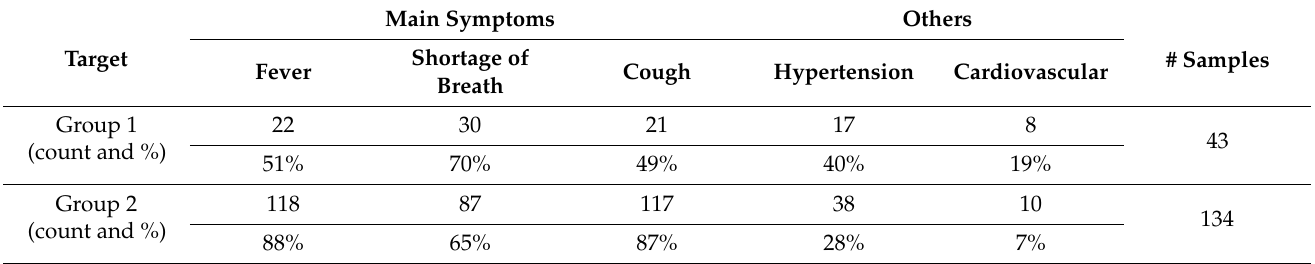
Table 12. Statistical results of the two groups constituted the used